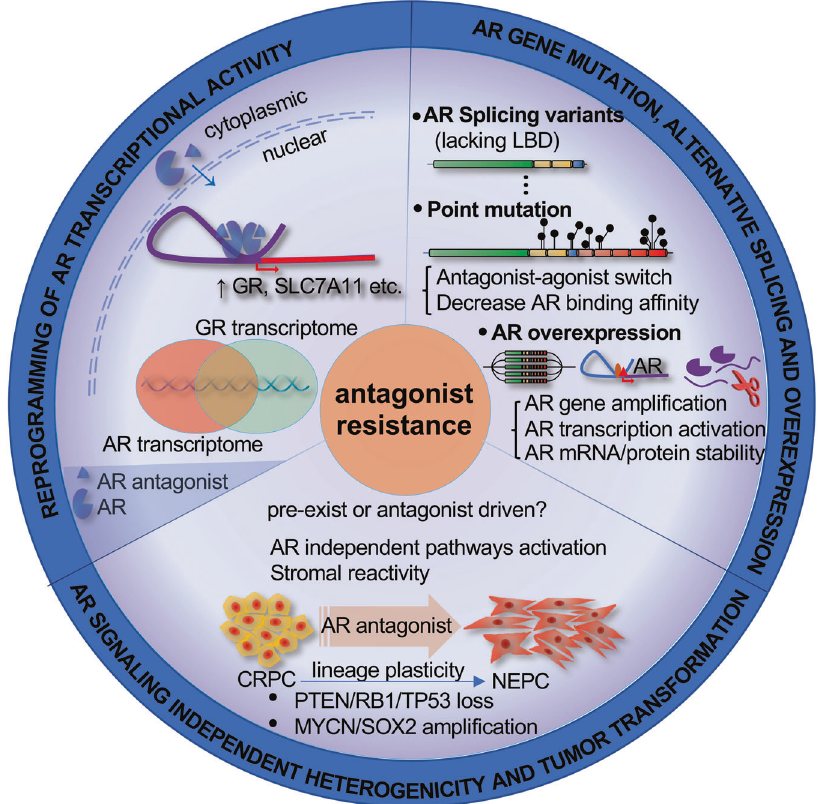
Fig. 4 Mechanisms of resistance to androgen receptor inhibitors in prostate cancer. The partial agonist role of second-generation AR antagonists induces the expression of cancer-related genes including GR. GR in turn regulates the expression of a set of genes that overlaps with AR downstream pathways. AR alterations can include alternative splicing, point mutation and overexpression. Other AR signaling- independent mechanisms such as PTEN/TP53/RB1 loss of function and MYCN/SOC2 activation can mediate CRPC progression and contribute to AR antagonist resistance in Table 2. Novel AR targeted therapies.